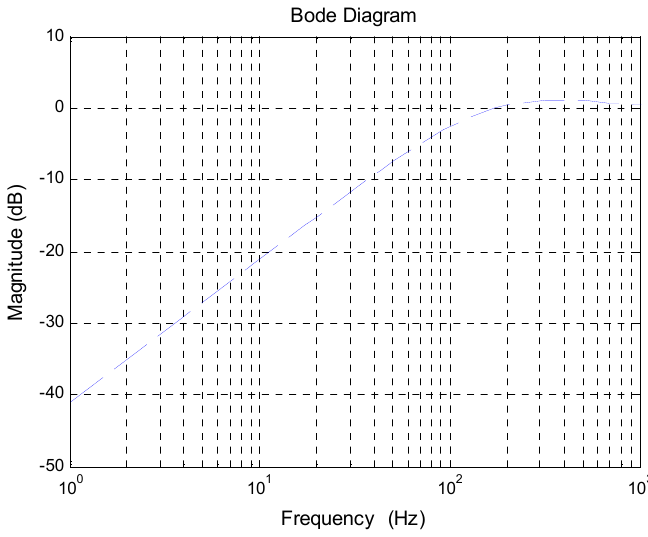
Figure 9. The simulation of DS improvement brought by FDOB.